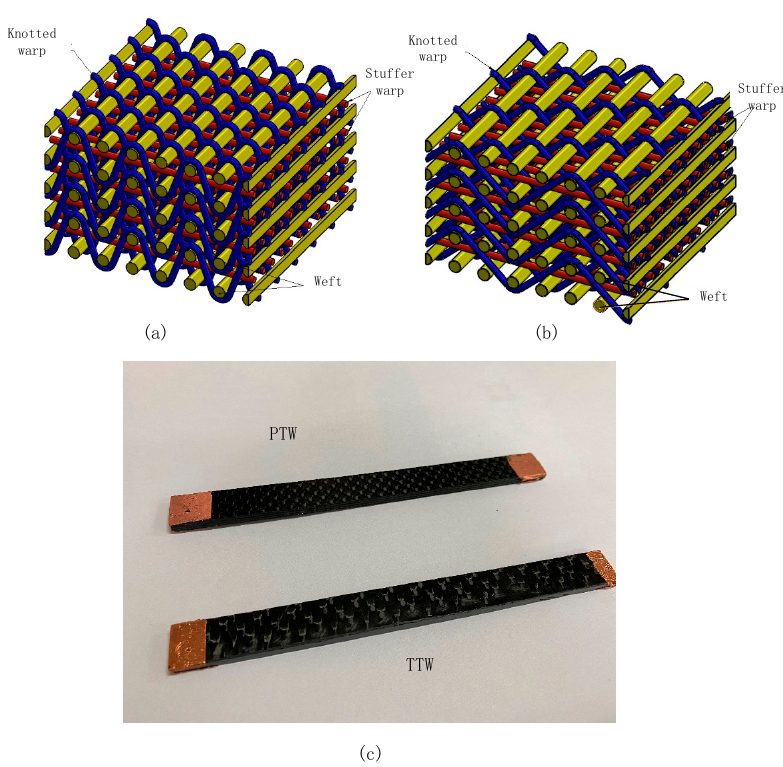
Figure 3. ( a ) Plain weave structure (PTW), ( b ) twill weave structure (TTW), and ( c ) sample physical picture. Table 1. Carbon fiber performance